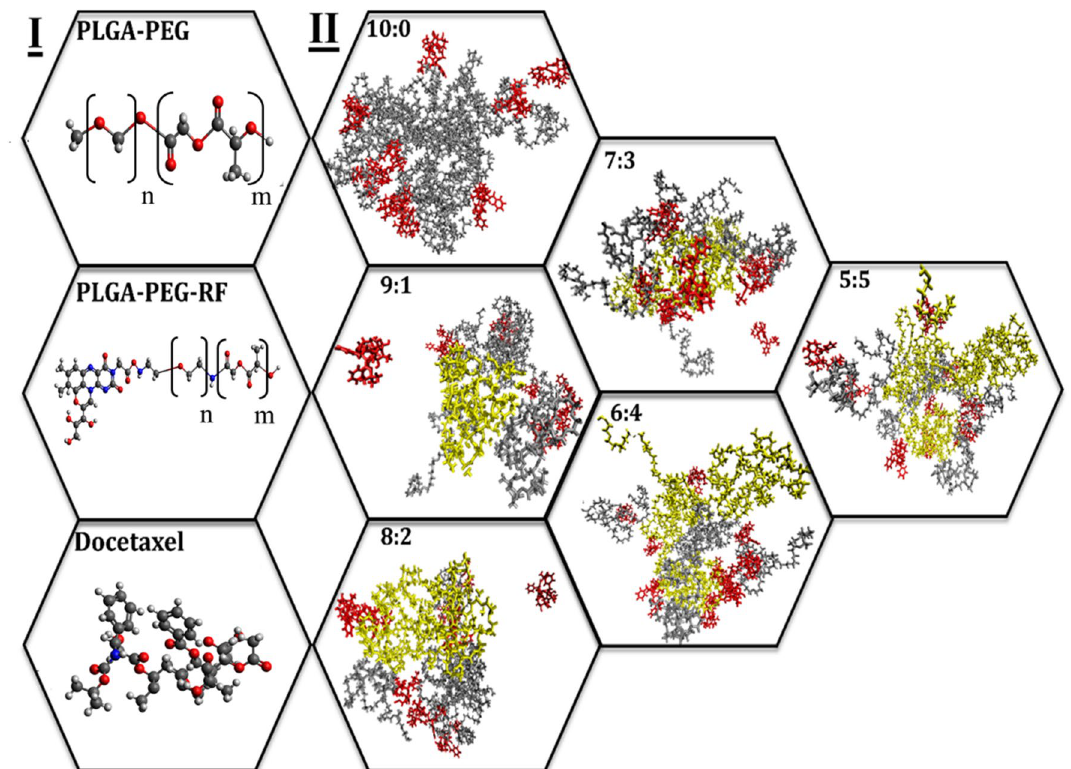
Figure 2. Graphical presentation of simulations; ( I ) Structure of docetaxel, PLGA-PEG, and PLGA-PEG-RF ( Nitrogen in the structure is blue, Carbon is silver, Oxygen ins red and Hydrogen is white ). ( II ) Drug-loaded RF-conjugated NPs formed within a 100 ns timespan at different PP:PPR ratios. PLGA-PEG, PLGA-PEG-RF, and drug molecules are represented in gray, yellow, and red,